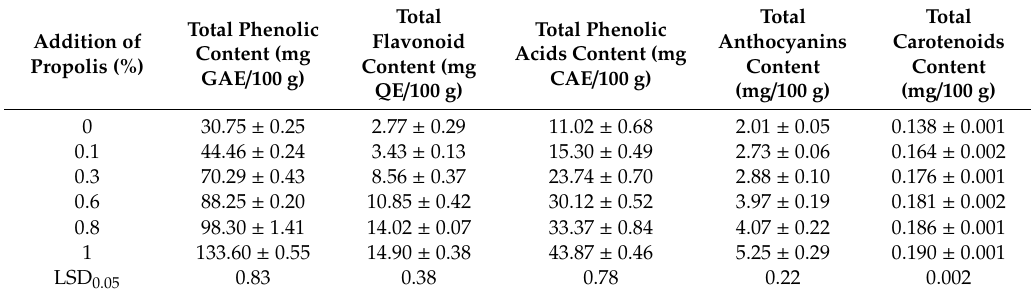
Table 1. The total phenolic, flavonoid, phenolic acids, anthocyanins, and carotenoids content in multifloral honey and honeys enriched with